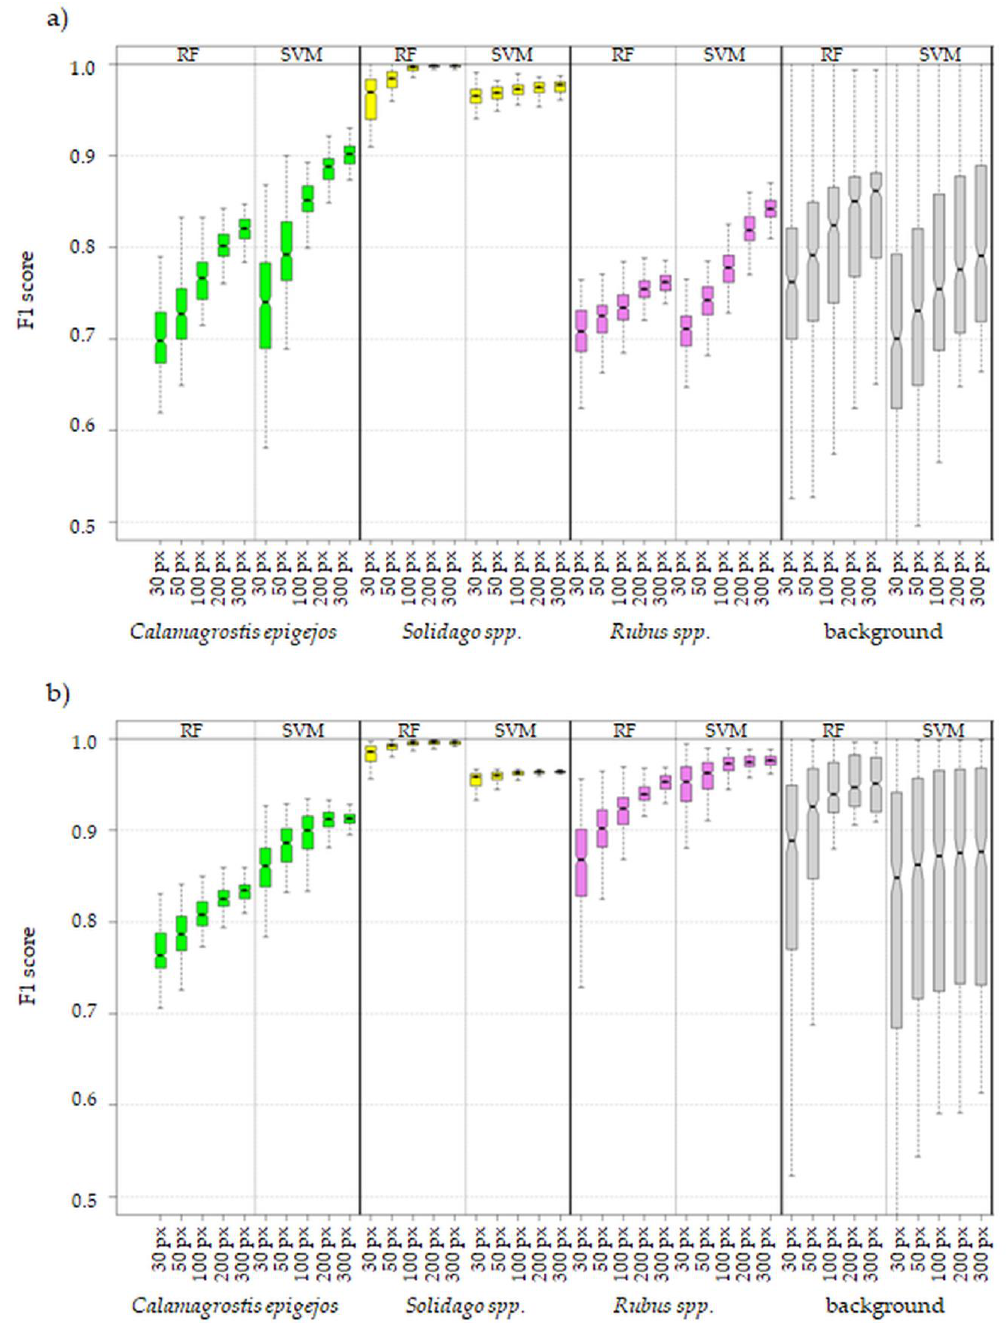
Figure 7. F1 score distribution for validation data set a) 430 bands and b) 30 MNF bands. The horizontal axis of the charts indicates the number of pixels in the training set used to classify the given species using RF or SVM classifiers. The vertical axis shows the accuracy of the scenarios. The Solidago spp. class identified well with all classifiers and raster data sets (the F1 score was above 0.95). The accuracy levels increased with an increasing number of training pixels, whereas the differences in accuracy levels resulting from the change in the size of the training sets were small. However, slightly higher mean F1 scores were recorded for the Random Forest classifier. Solidago are